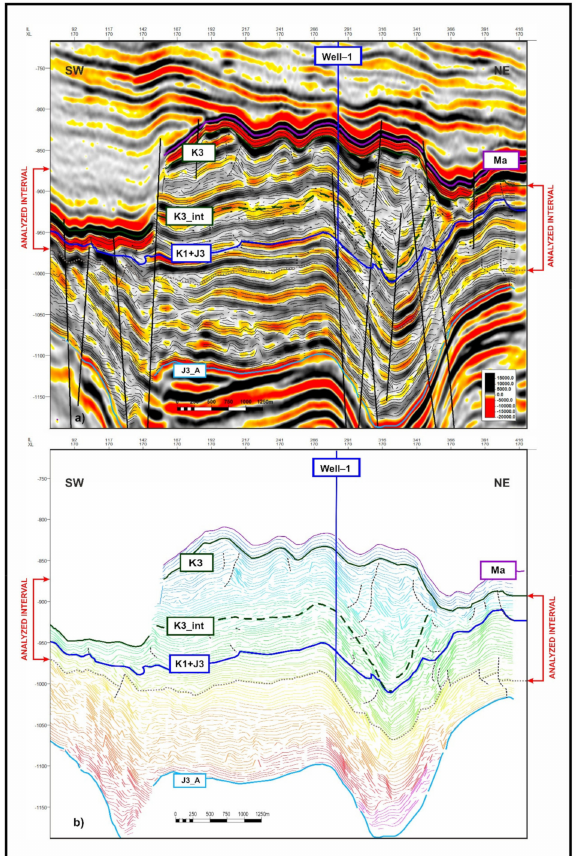
Figure 3. Main seismic horizons shown against chronostratigraphic horizons calculated by the data-driven approach: ( a ) chronostratigraphic horizons shown at the background of the time seismic section; ( b ) chronostratigraphic horizons in the color